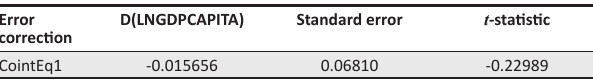
TABLE 6: Vector error correction model estimation results and